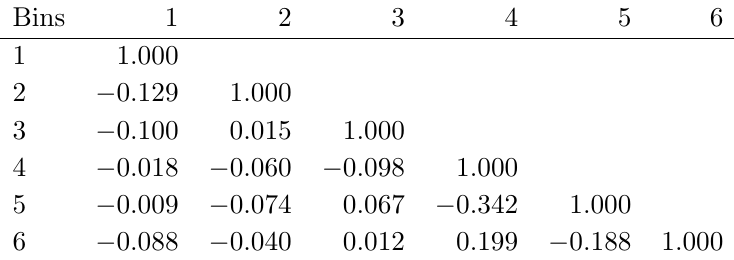
Table 5 . Correlation matrix for the six correlated bins of the combined